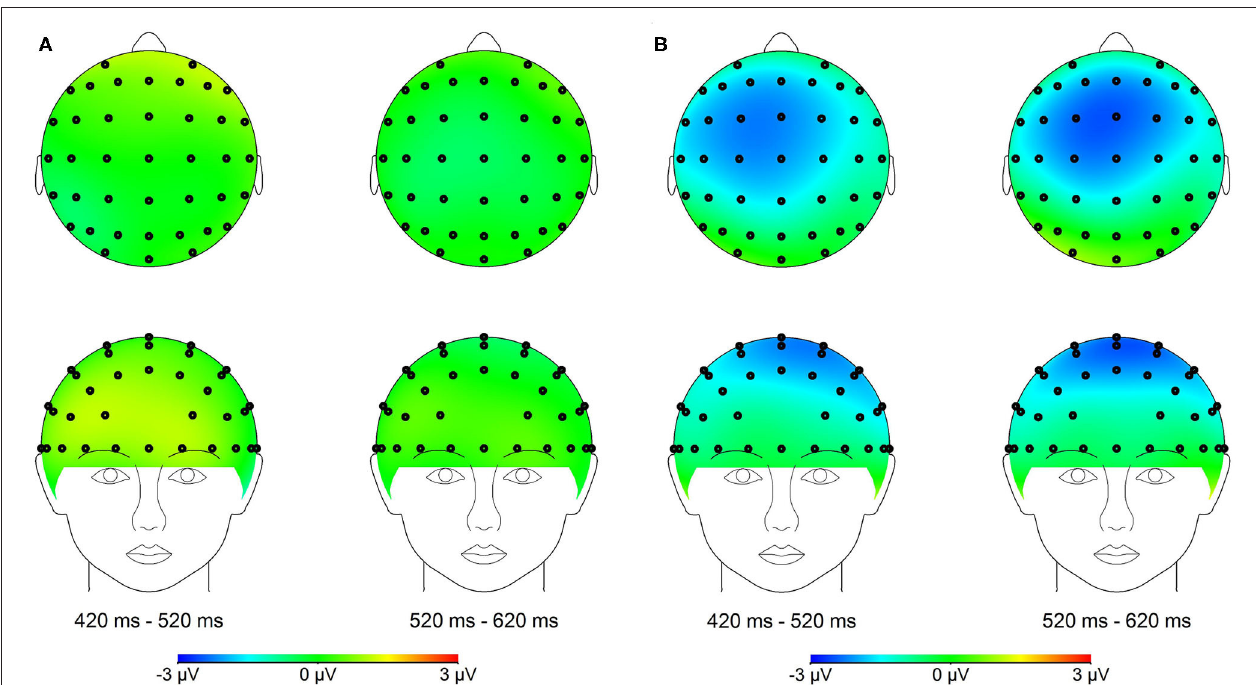
FIGURE 3 | (A) Topographical maps of the voltage amplitudes for the PMM minus PM difference wave in the 420–620ms time range. (B) Topographical maps of the voltage amplitudes for NMM minus NM difference wave in the 420–620ms time